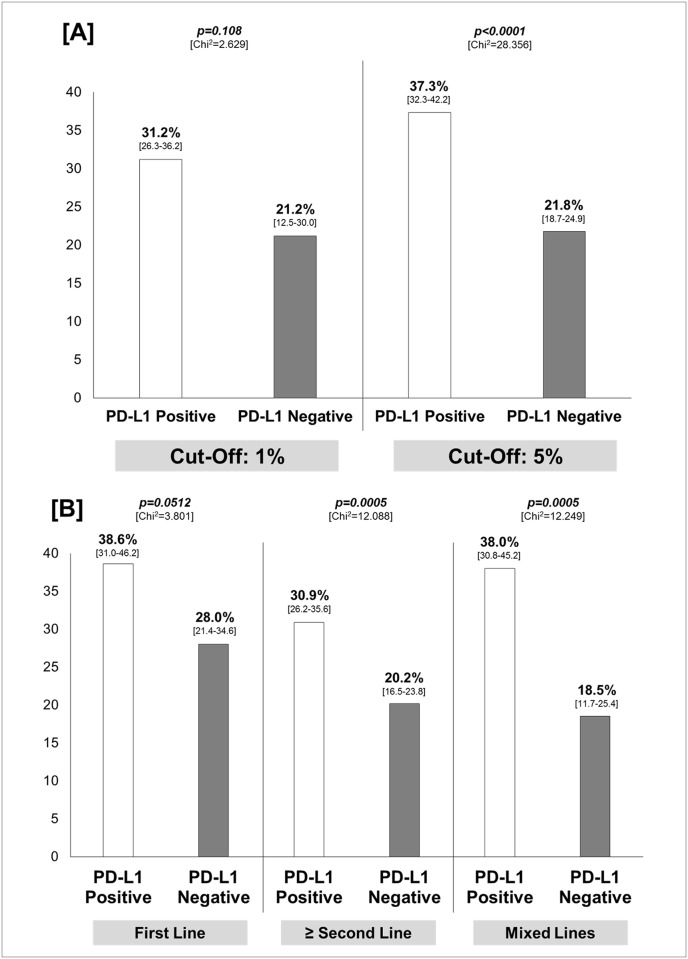
Results of the sensitivity analysis.
Panel [A]: overall response rate, with 95% confidence interval in square brackets, according to PD-L1 expression cut-off; Panel [B]: overall response rate with 95% confidence interval in square brackets, according to treatment line. Chi2: Chi-square test; PD-L1: programmed death-ligand-1.